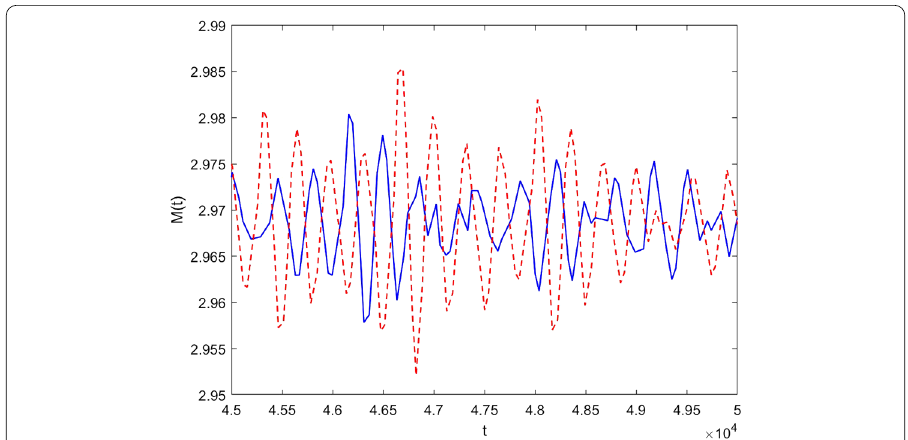
Figure 8 A computer simulation of the system (2.1)–(2.2) with a 1 = 0.1450, a 2 = 0.6937, b 1 = 0.0596, b